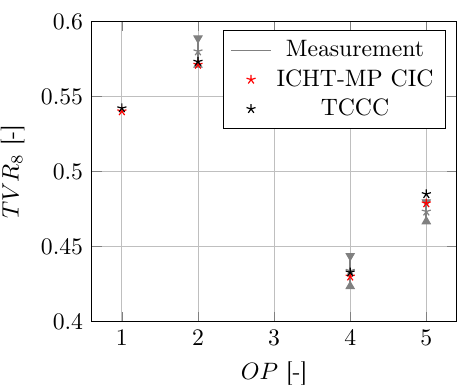
Figure 8. Results for temperature sensor 8 (TVR8) for the cooled operating points. All results obtained using the steady state approach using the CHT-MP are in very good agreement 302 with the transient results. The numerical values for non-dimensional wheel temperature (TVR) are in 303 the range of the uncertainty of the measurement campaign. 304